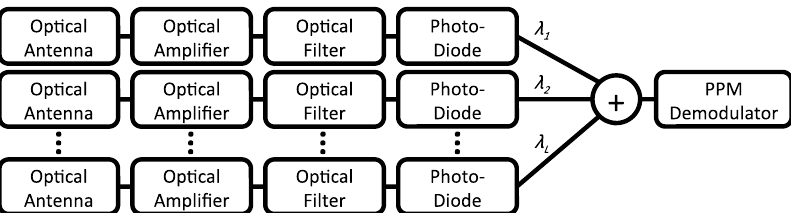
Figure 1. Amplification and diversity with equal-gain-combining. PPM: Pulse position